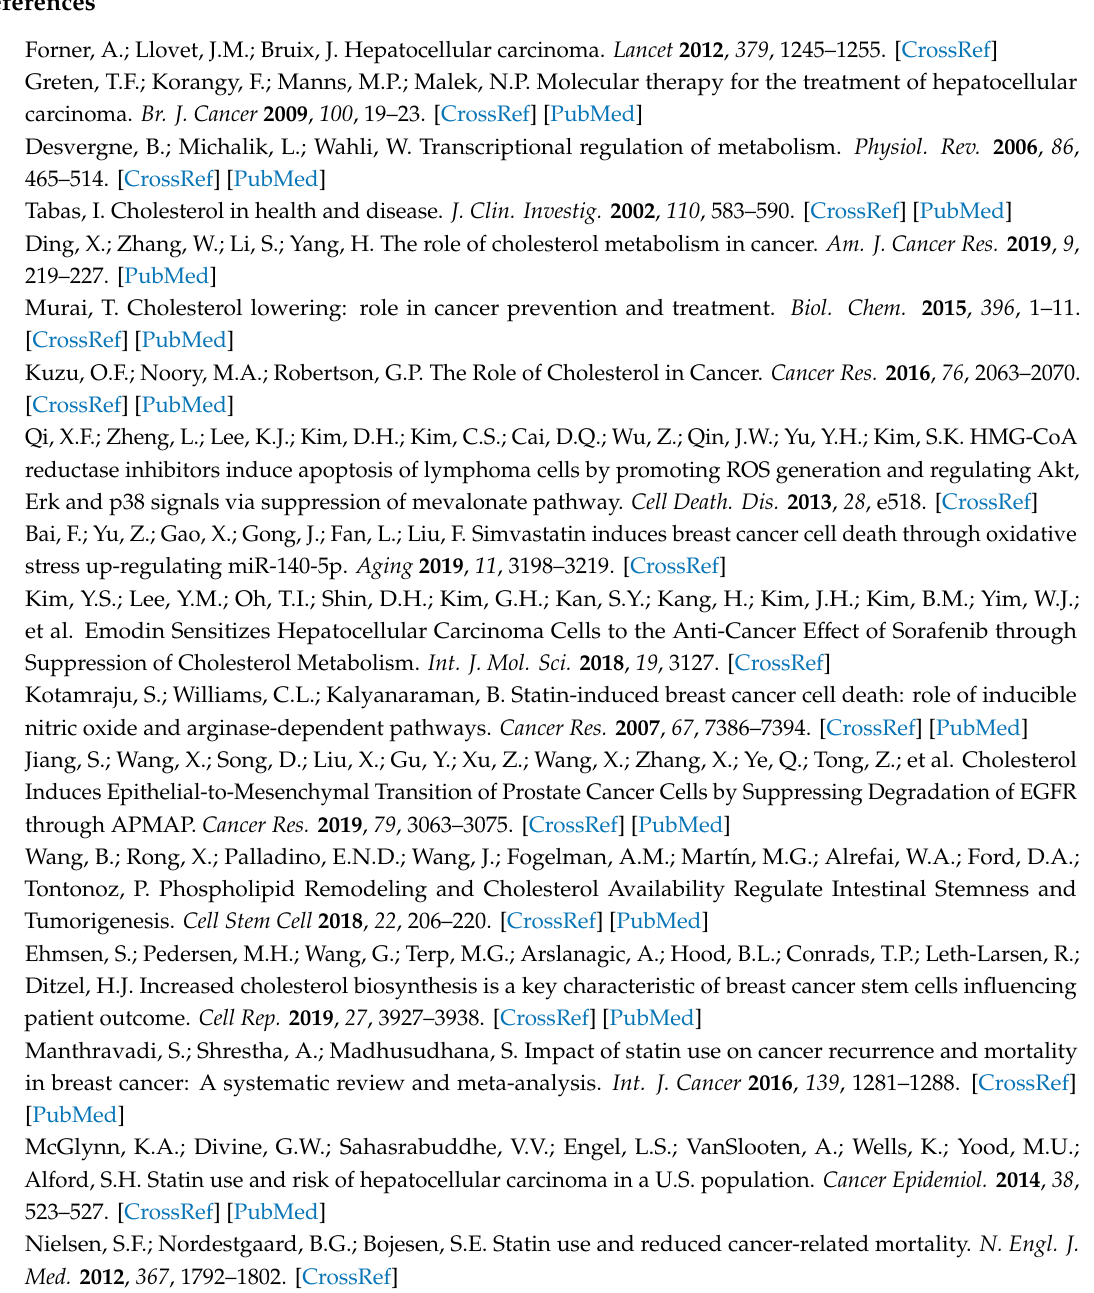
Figure S1: Whole Scan of Western Blots Film, Table S1: Densitometry analysis of Western Blots. All band intensities were normalized to control band in each experimental